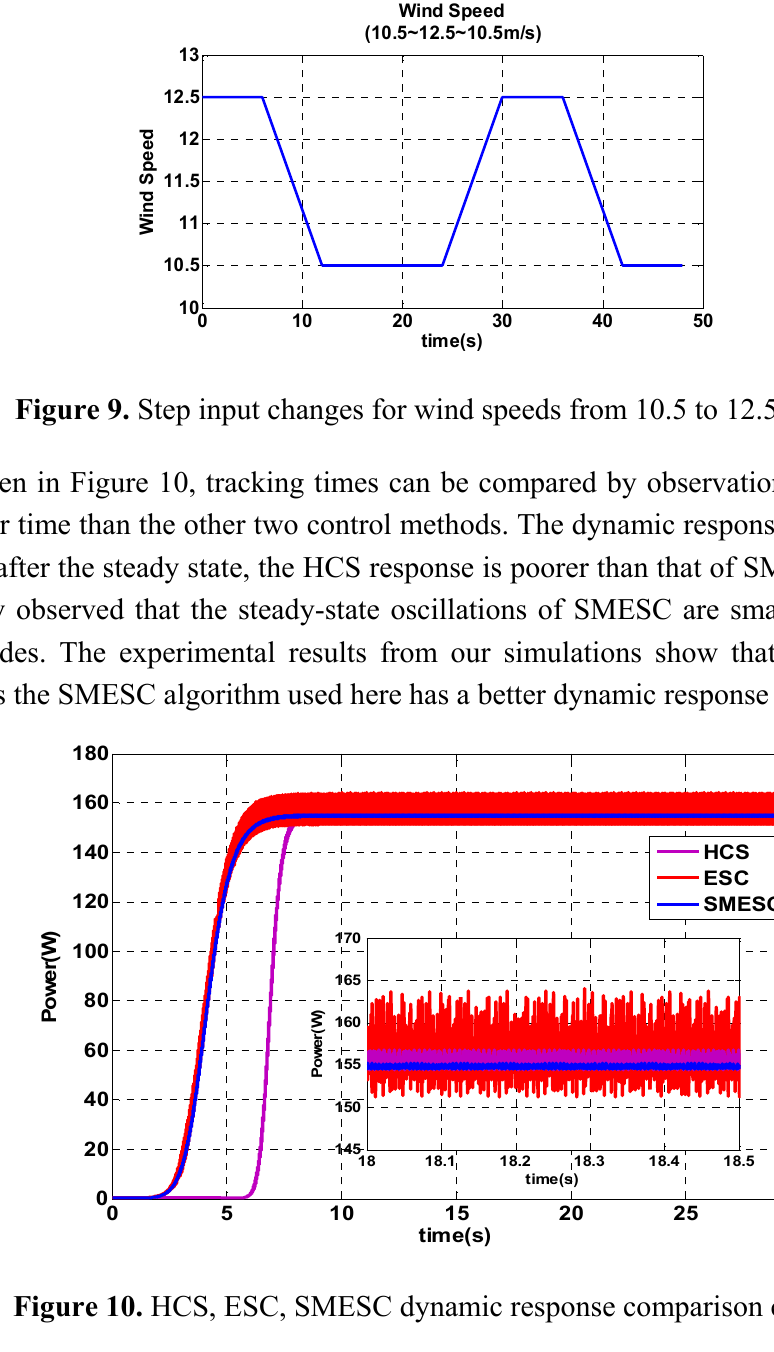
Figure 8. Step input for wind speed of 12 m/s.